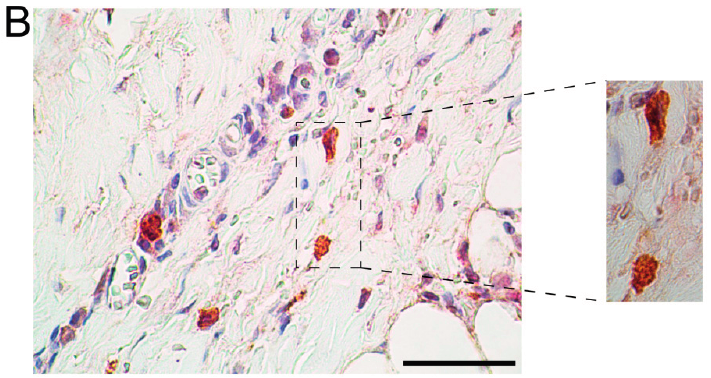
Figure 3. Double-staining with antibodies against HCST (red) and GMZB (brown) in AAA tissue. The donors were WSU060 ( A ); and WSU052 ( B ) for the AAA tissues used in the staining shown in the upper and lower panels, respectively. See Tables 1 and 2 for details on the aortic tissues and antibodies used, respectively, and Supplementary Figure S1 for additional images. Scale bar = 50 µm.